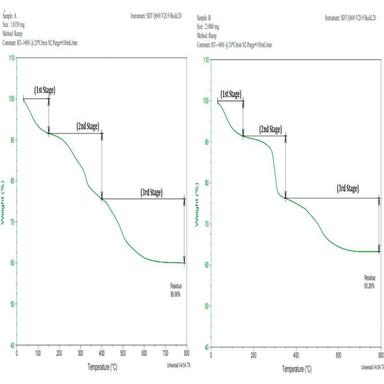
TGA spectra of PMA, PMAA, PMAB hybrid materials.